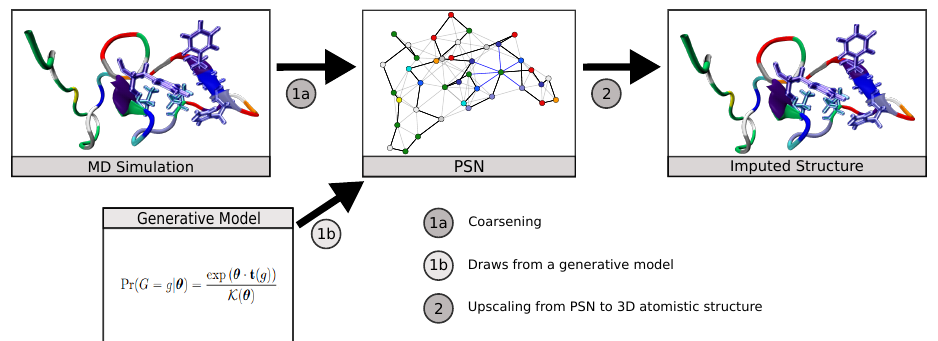
Figure 1. The ability to impute atomistic structures from network representations enables both compressive representation of structures from MD trajectories and the use of generative network models to predict distributions of atomistic